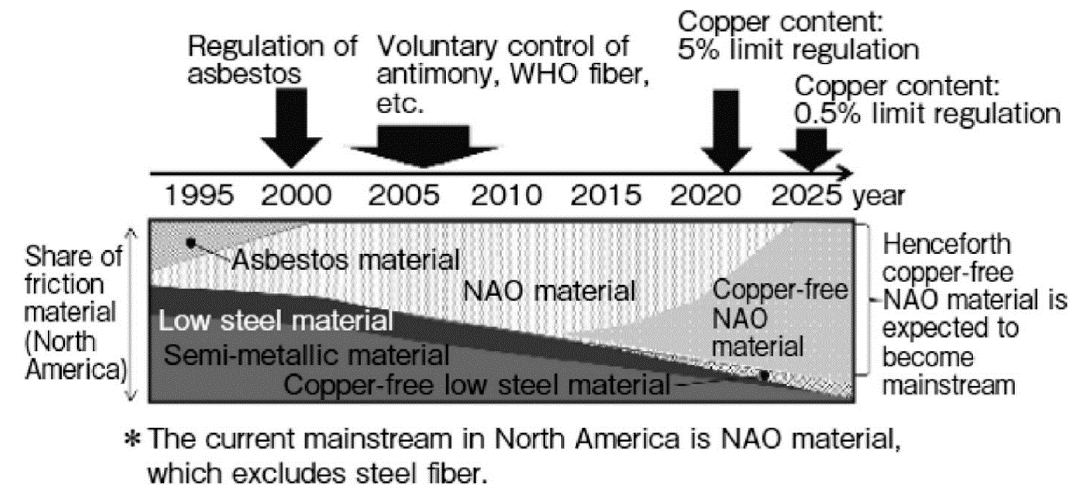
Figure 1. History of changing regulations of the compounds used in North America [21].